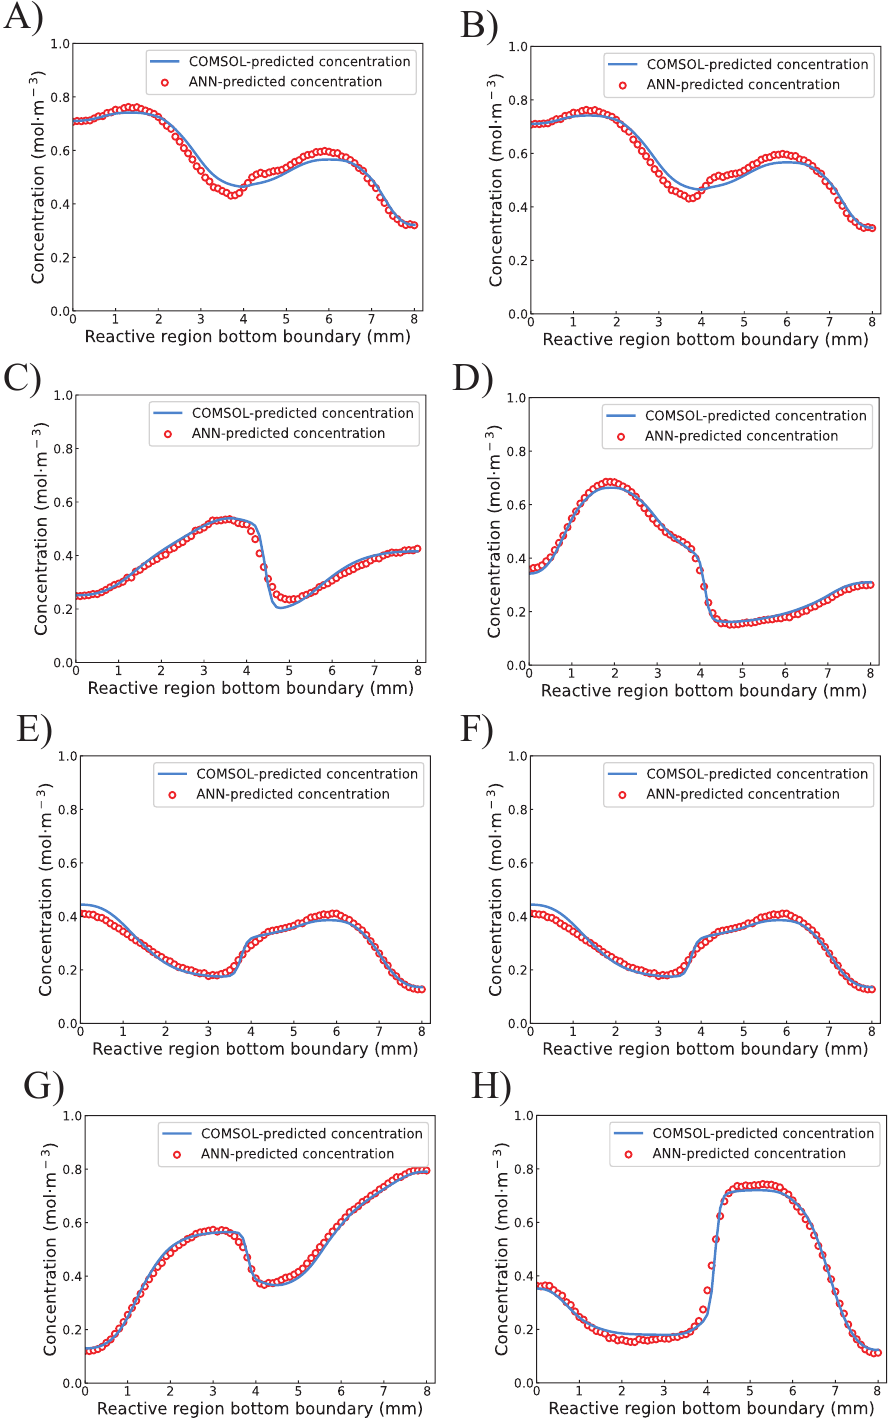
Figure 7. The comparision between ANN-predicted and COMSOL-predicted concentration values on the bottom boundary of the reactive region from design ( A – H